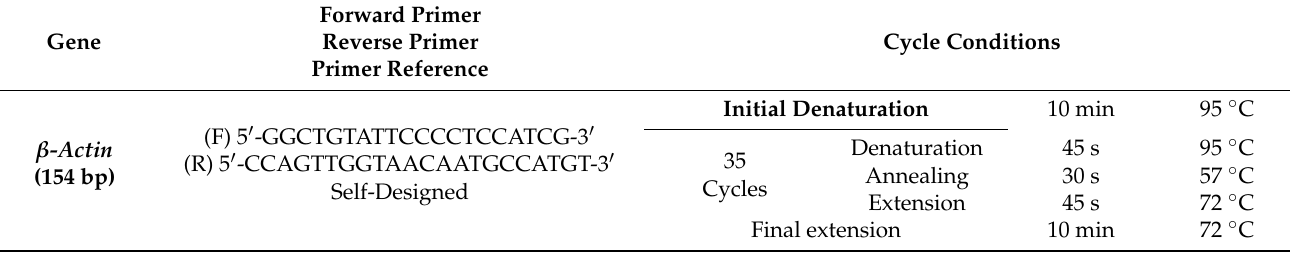
Table 3. Overview of used primer pairs for RT-PCR including cycle conditions.